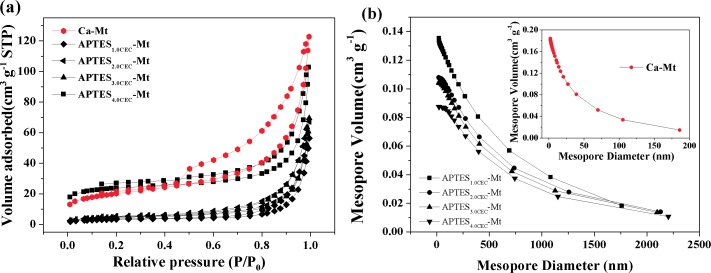
Nitrogen adsorption-desorption isotherms of Ca-Mt (a) and APTES-Mts (c); BJH pore size distribution of Ca-Mt (b) and APTES-Mts (d).